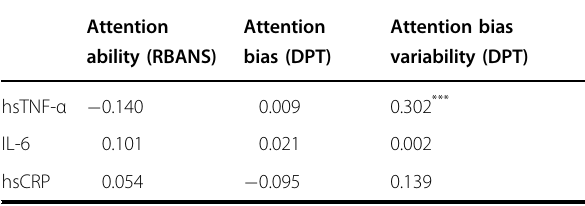
Table 3 Correlations between proin fl ammatory marker levels and attention indices in a subset of participants ( n =